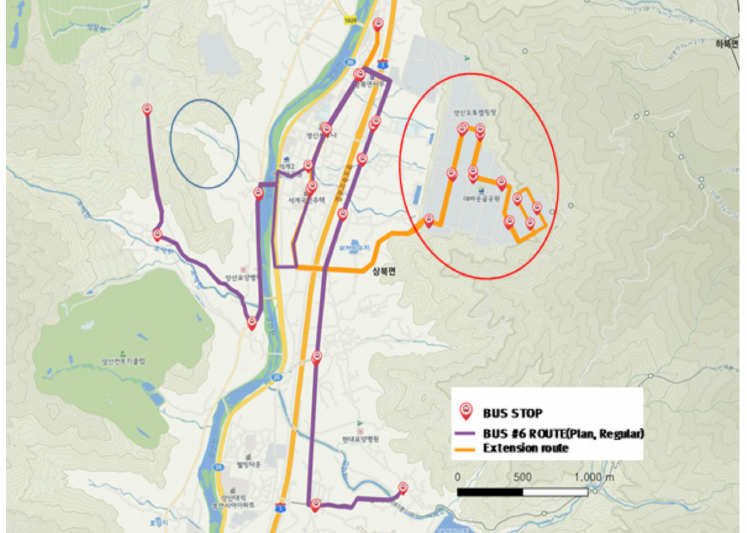
Figure 21. City-type bus No. 6